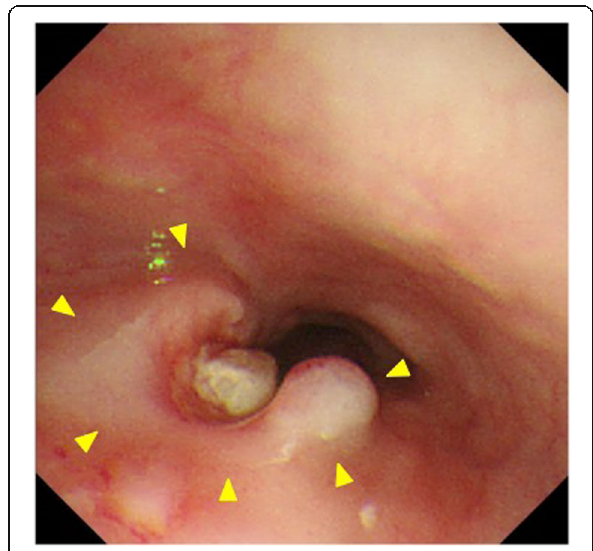
Fig. 6 Retrograde endoscopy through the route of the drainage tube inserted into the esophagus revealed a protruded tumor ( arrowhead ) at the right and posterior wall of the middle thoracic esophagus